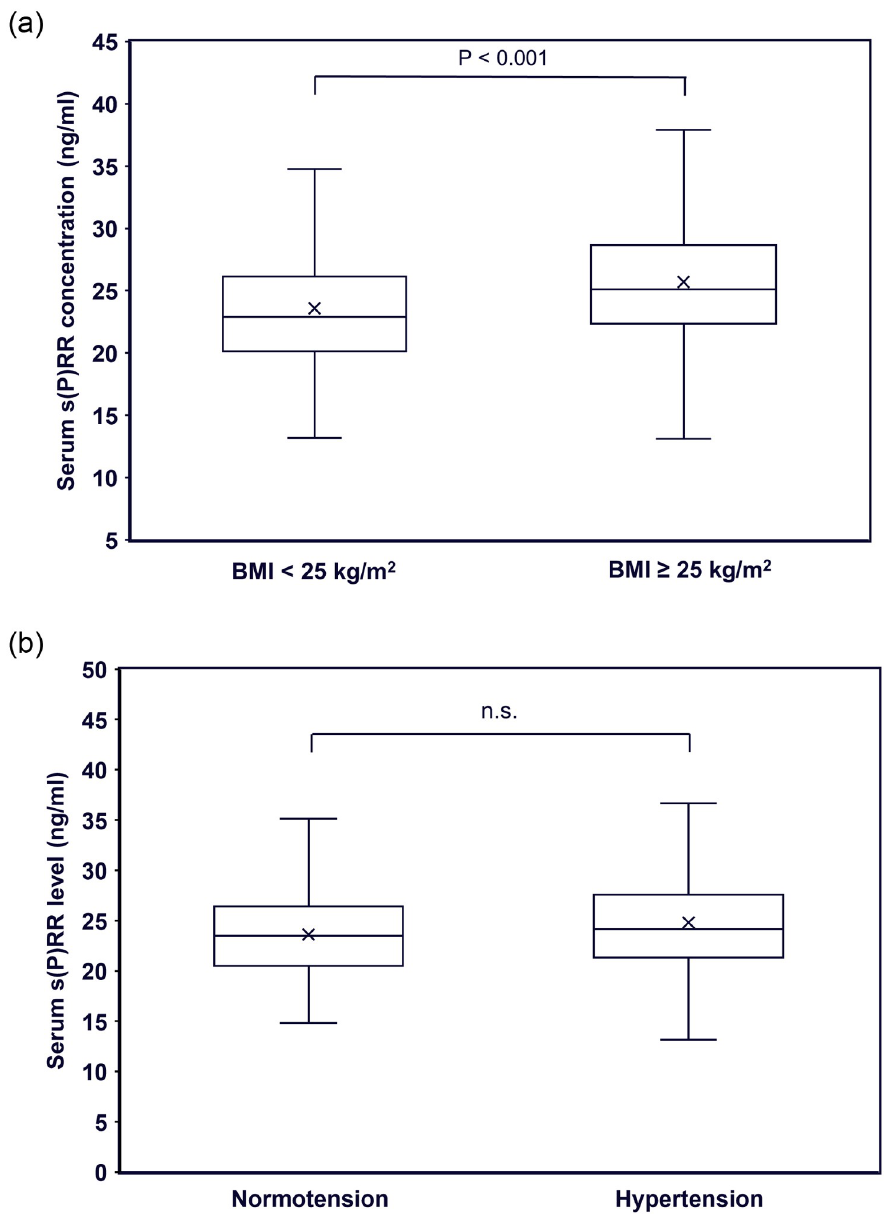
Fig 4. Comparisons of serum s(P)RR concentration between patients with and without obesity (a) and those with and without hypertension (b). s(P)RR, soluble (pro)renin receptor; BMI, body mass index.